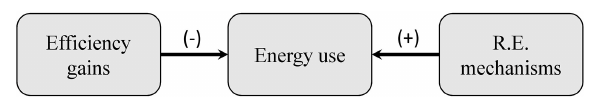
FIGURE 3 | Rebound effect (R.E.) as external to, and independent from, efficiency gains.